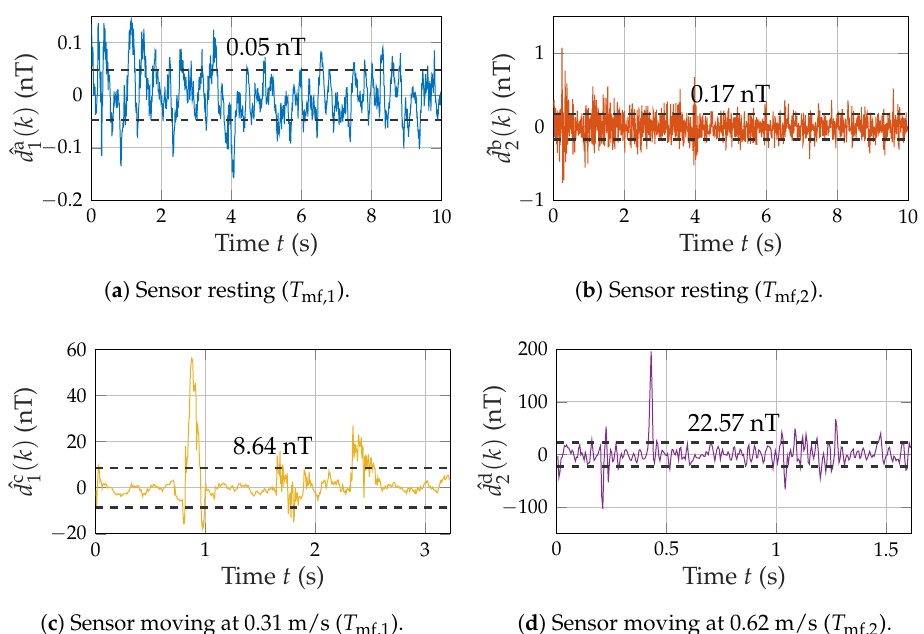
Figure 9. Noise measurements of moving and resting sensors. Each plot contains the noise at the matched filter output and the corresponding RMS value from σ a